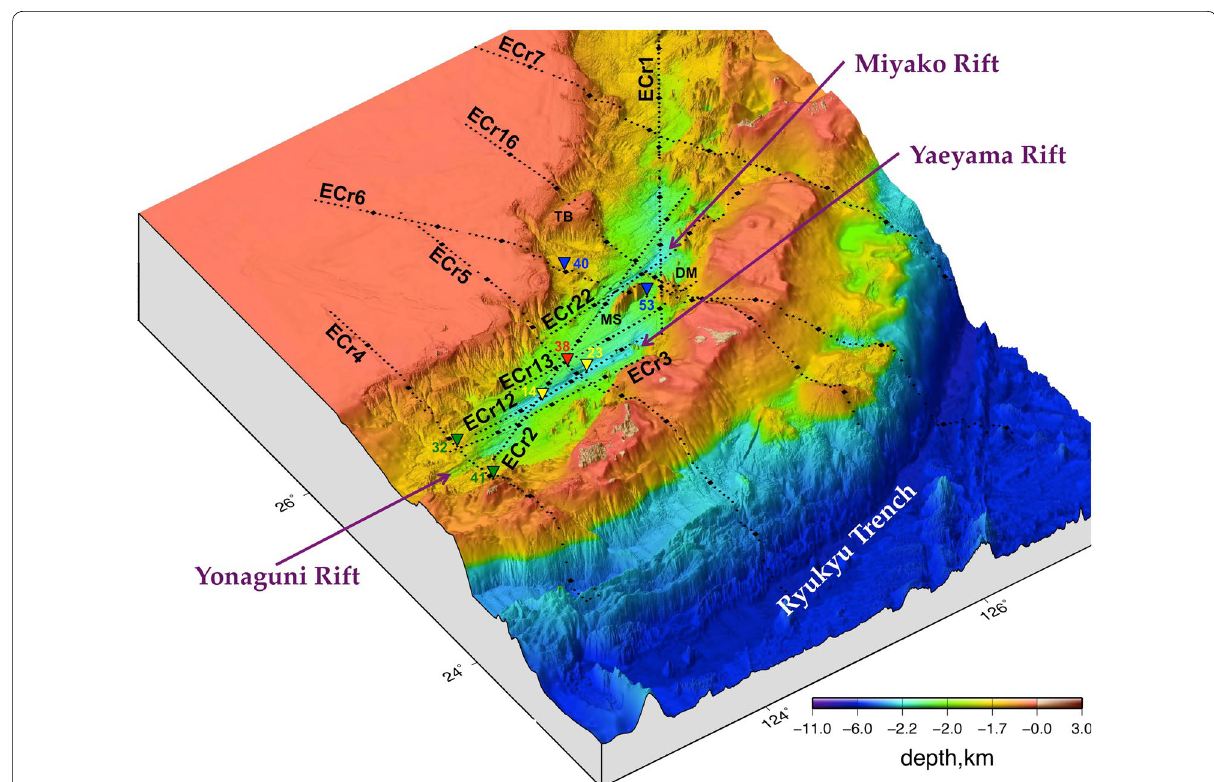
Fig. 2 Three-dimensional view of the fine bathymetry in the southern OT and the position of the seismic lines. The OBSs were deployed at each square. TB Taisho Bank, DM Daiichi–Miyako Knoll, MS Miyako